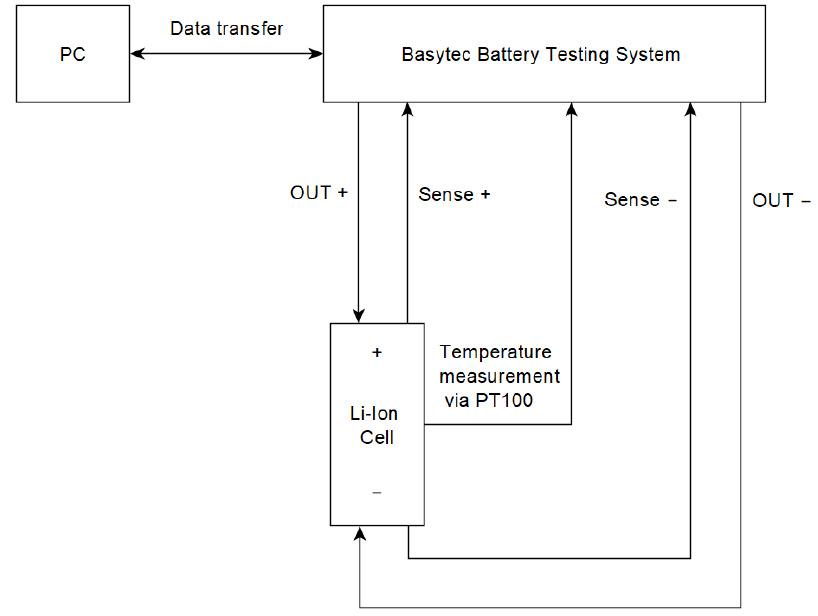
Figure 1. Schematic of the measurement circuit for the lithium-ions cells with battery testing system and four wire method.